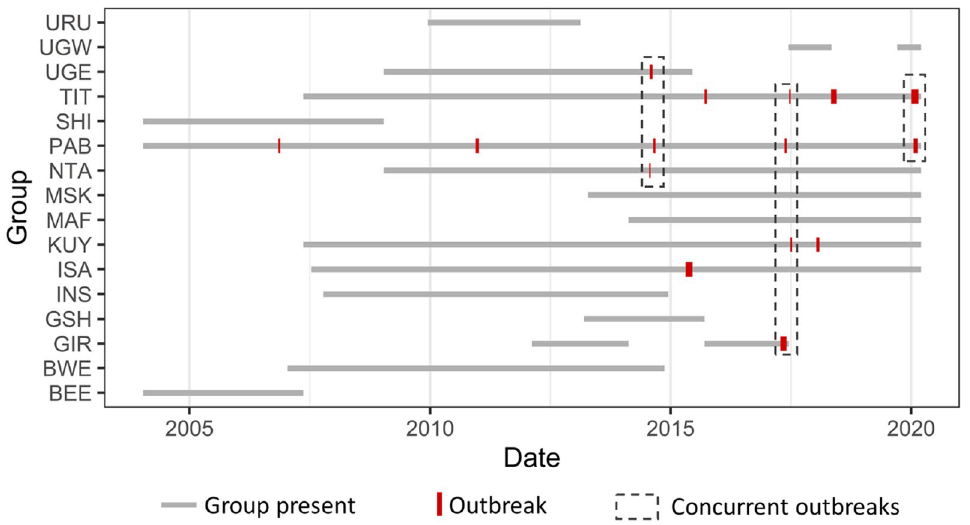
Figure 5. Timing of respiratory disease outbreaks among mountain gorilla groups monitored between 2004 and 2020. Concurrent outbreaks were defined as those that occurred within a month of each